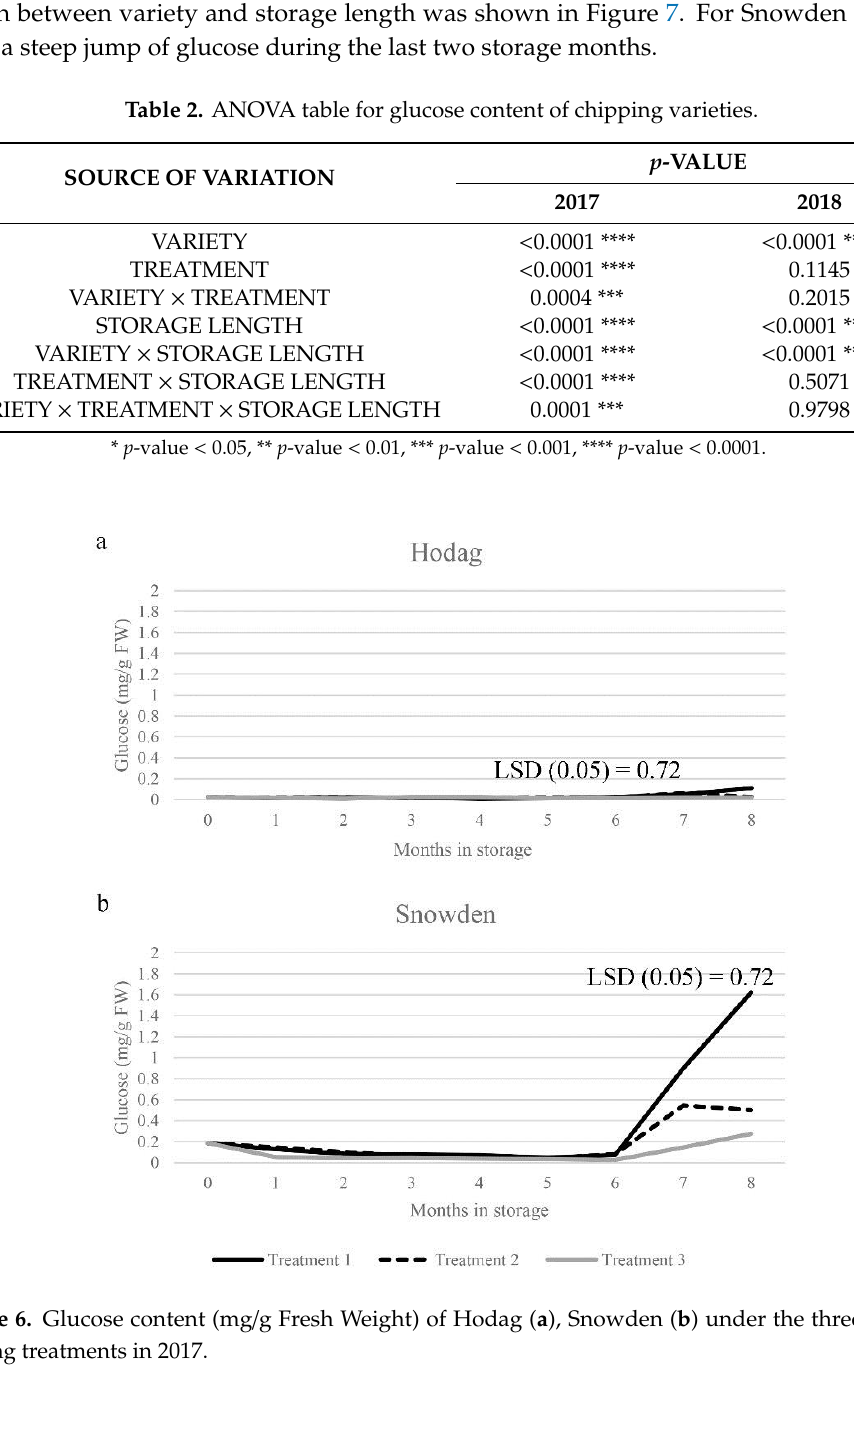
Figure 5. Cumulative monthly weight loss % of Hodag ( a ), Snowden ( b ), Lamoka ( c ) and Russet Burbank ( d ) under the three wound healing treatments in 2018. LSD (α = 0.05) between each monthly weight loss measurement is 0.7% among varieties and treatments.